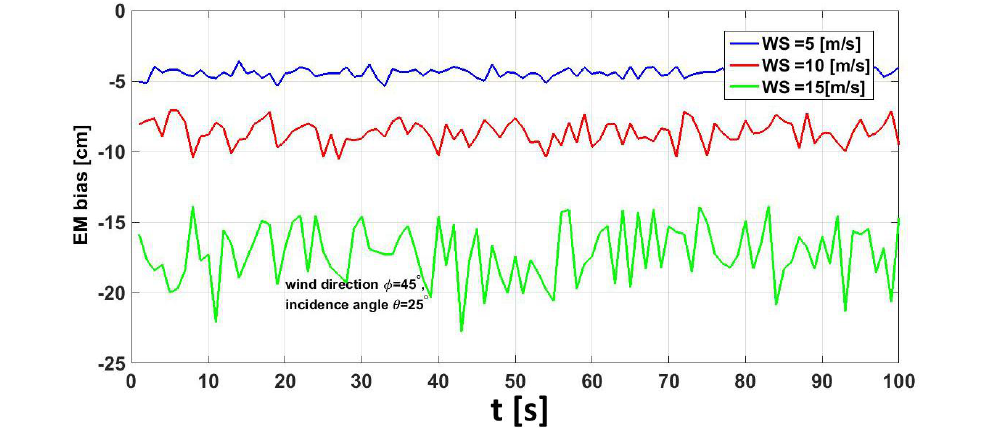
Figure 5. Computed time-evolution of the EM bias for wind speed WS = 5, 10, and 15 m/s, incidence/scattering angle θ i